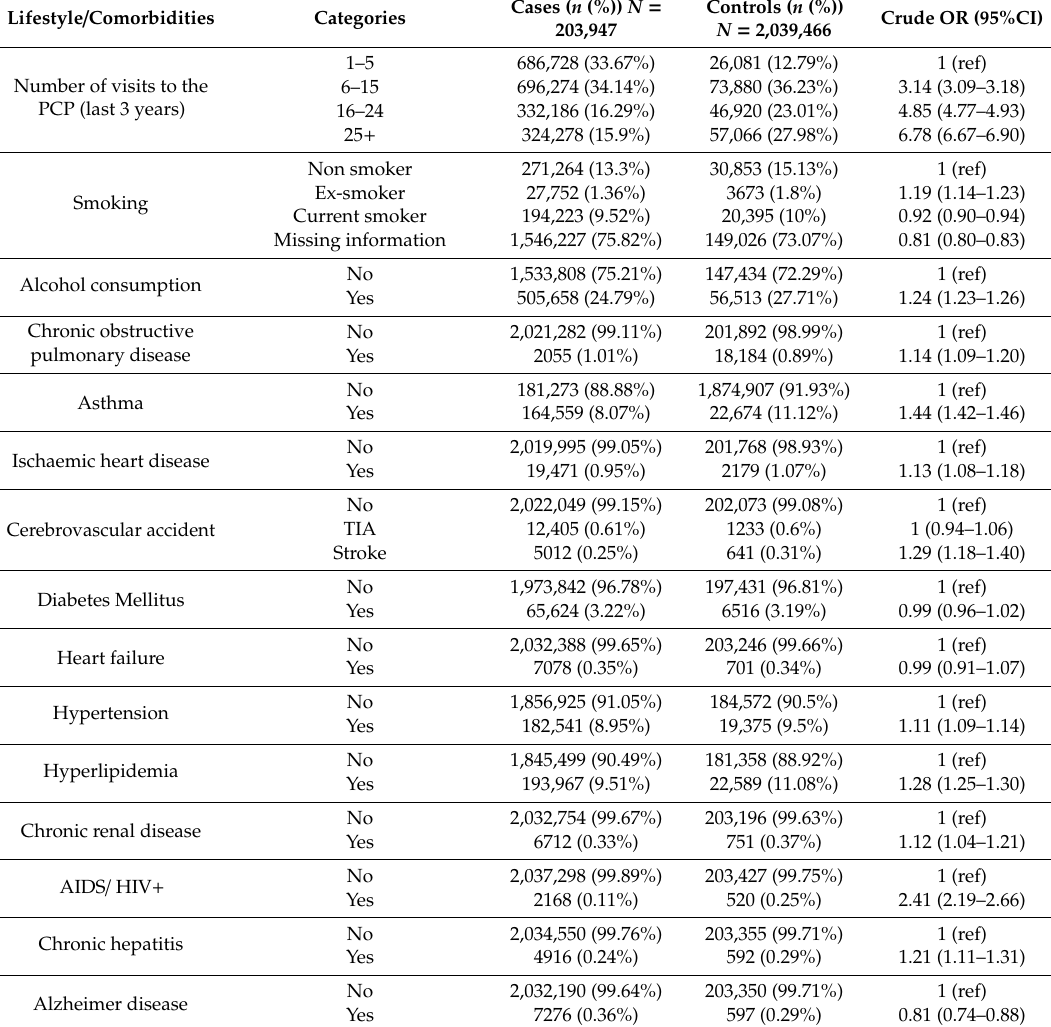
Table 3. Lifestyle and comorbidities distribution between cases and